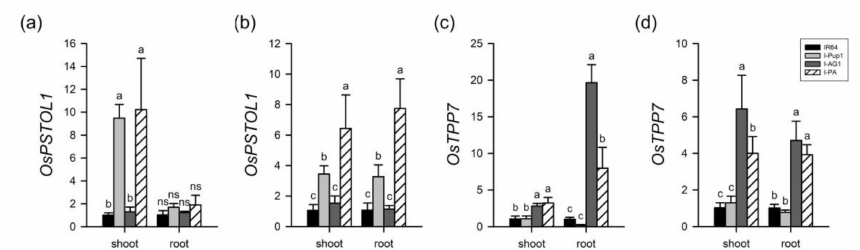
Figure 4. Transcriptional levels of PSTOL1 and OsTPP7 , the major genes of Pup1 and AG1 QTL, under P non-supplied condition ( a , c ) and P-supplied condition ( b , d ) using two WAT plants. Expression levels of major genes were normalized using the 2 − ∆∆ Ct method. The letters above bars represent statistical significance ( p < 0.01) as measured by Duncan’s multiple range test. ns: no significant di ff